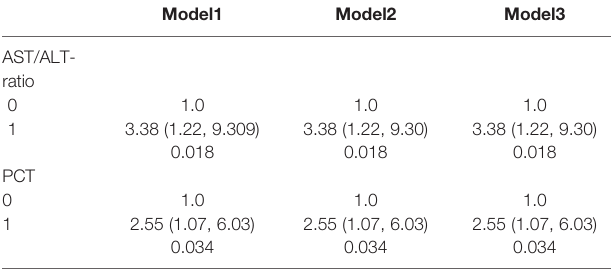
TABLE 8 | Multivariate cox regression analysis of risk factors for disease prognosis.